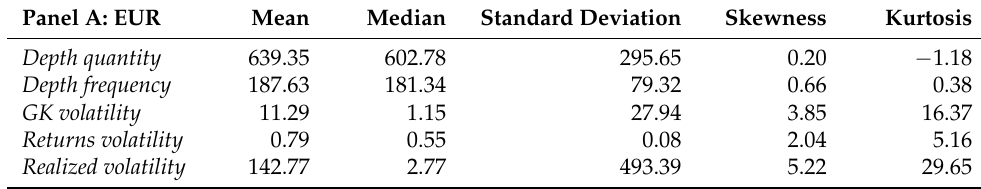
Figure 1. The intraday depth and volatility behavior. This figure presents the intraday behavior of the depth and volatility measures over the day using 15-min time intervals. ( a ) depicts EUR futures depth, ( b ) depicts EUR futures volatility, ( c ) depicts Gold futures depth, ( d ) depicts Gold futures volatility, ( e ) depicts Corn futures depth, and ( f ) depicts Corn futures volatility. Depth quantity is calculated as the sum of the depth available across all five levels in the limit order book. Depth frequency is calculated as the sum of the number of orders available across all five levels in the limit order book. GK volatility is the Garman and Klass (1980) volatility measure composed of the high, low, open, and close values in an interval. Returns volatility is calculated as the absolute value of returns across intervals. Realized volatility is the sum of squared returns in each interval. In this figure, the Realized volatility is divided by 10 to adjust for scale. Table 1. Summary statistics of depth and volatility. This table presents the summary statistics of the depth and volatility measures for the fifteen-minute time intervals averaged over the sample period. Depth quantity is calculated as the sum of the depth available across all five levels in the limit order book. Depth frequency is calculated as the sum of the number of orders available across all five levels in the limit order book. GK volatility is the Garman and Klass (1980) volatility measure composed of the high, low, open, and close values in an interval. Returns volatility is calculated as the absolute value of returns across intervals. Realized volatility is the sum of squared returns in each